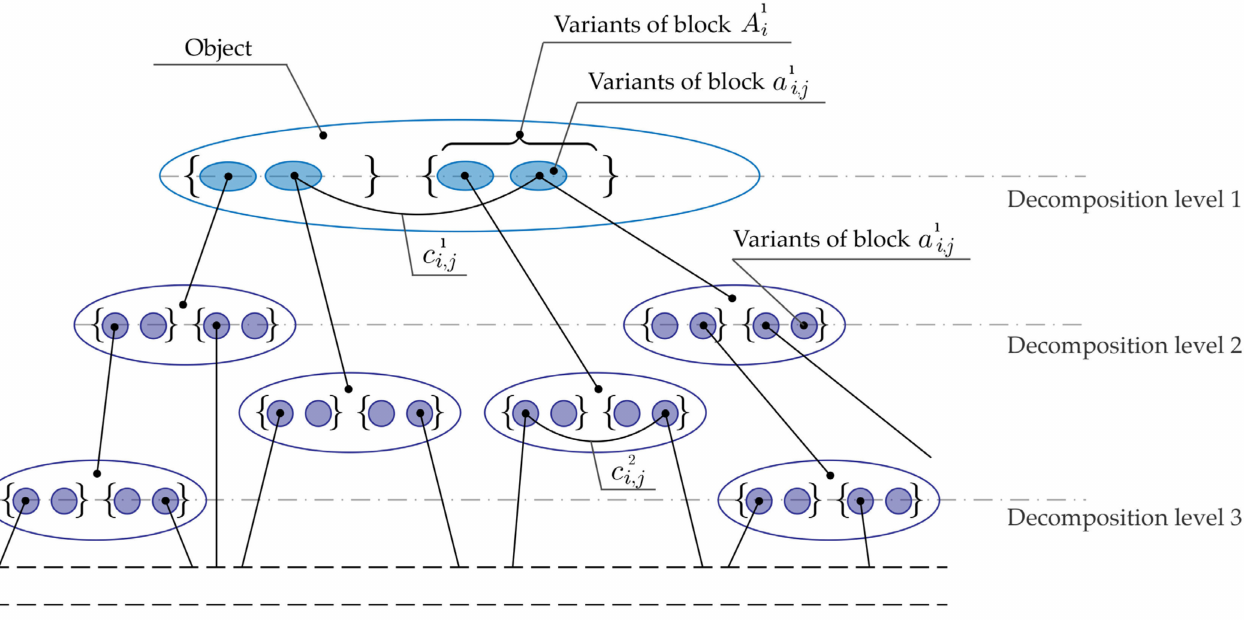
—a block variant, i , j —block i , j